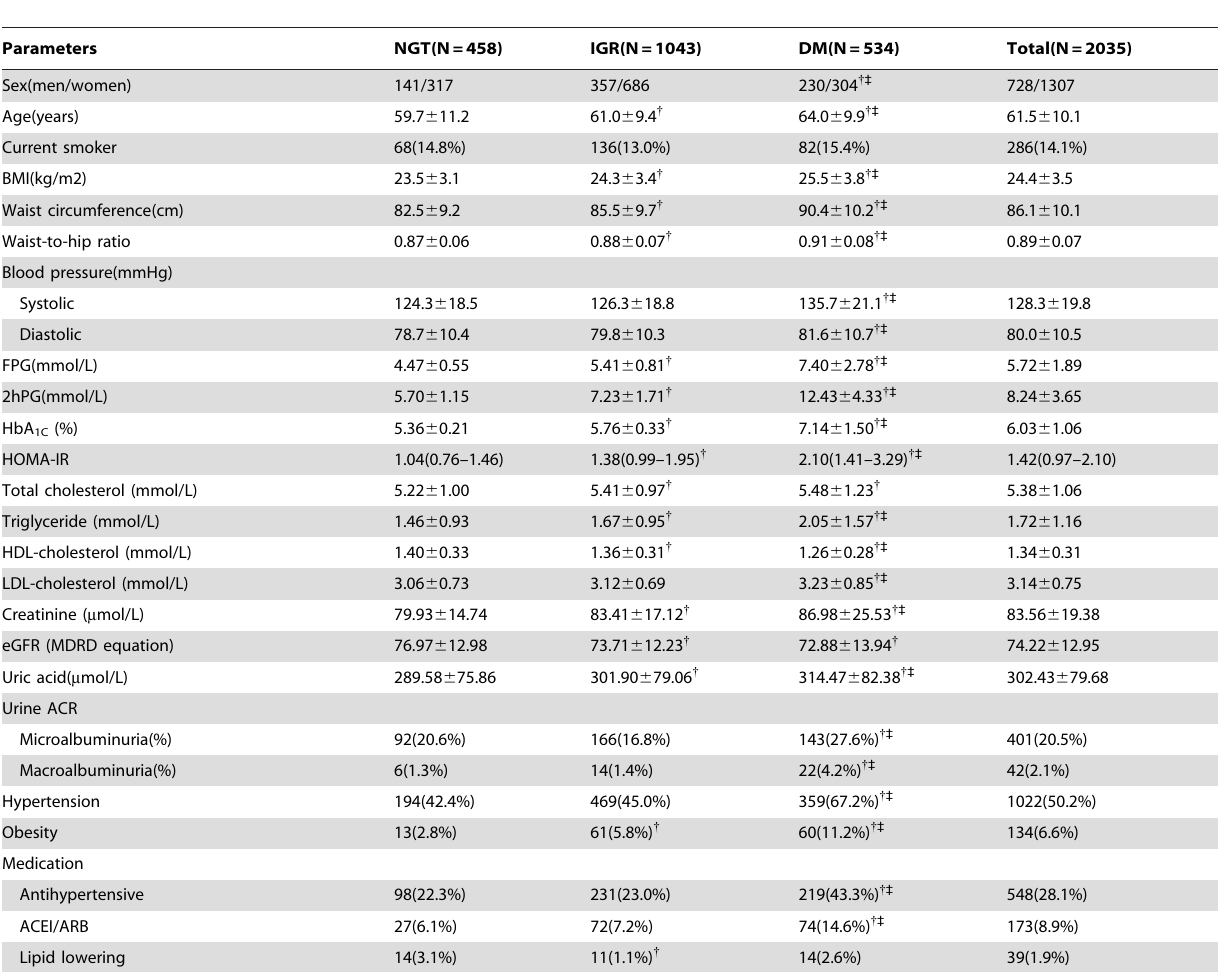
Table 1. Clinical characteristics of study population by group of normal glucose tolerance (NGT),impaired glucose regulation(IGR) and